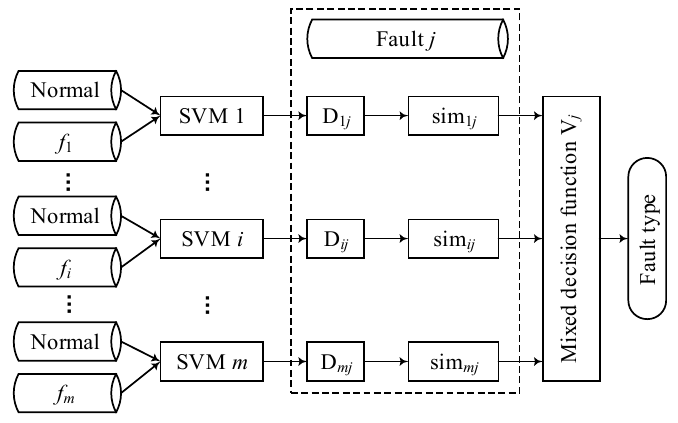
Figure 4. SVM ensemble classifier based on a mixed decision.